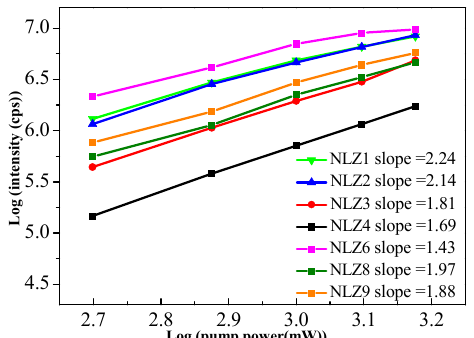
Fig. 6 Log–log plot of the green emission intensity versus the pump power of NLZ m ( m = 1, 2, 3, 4).